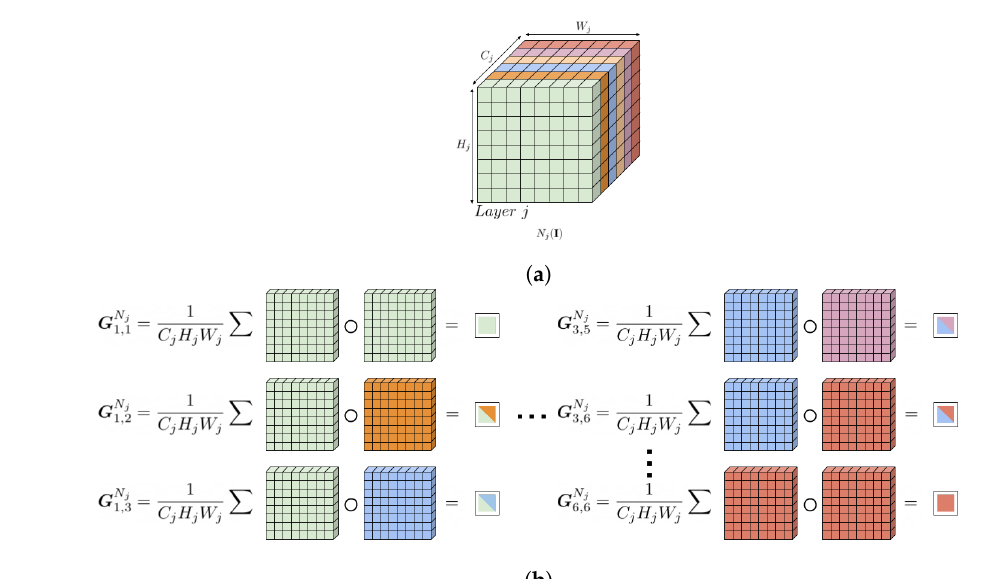
Figure 2. Schematic view of Gram matrix computation. In ( a ) is reported the feature maps of the j -th layer. ( b ) illustrate, for some of the indices of the Gram matrix, how they are computed. With the symbol ◦ we refer to the element-wise matrix product.